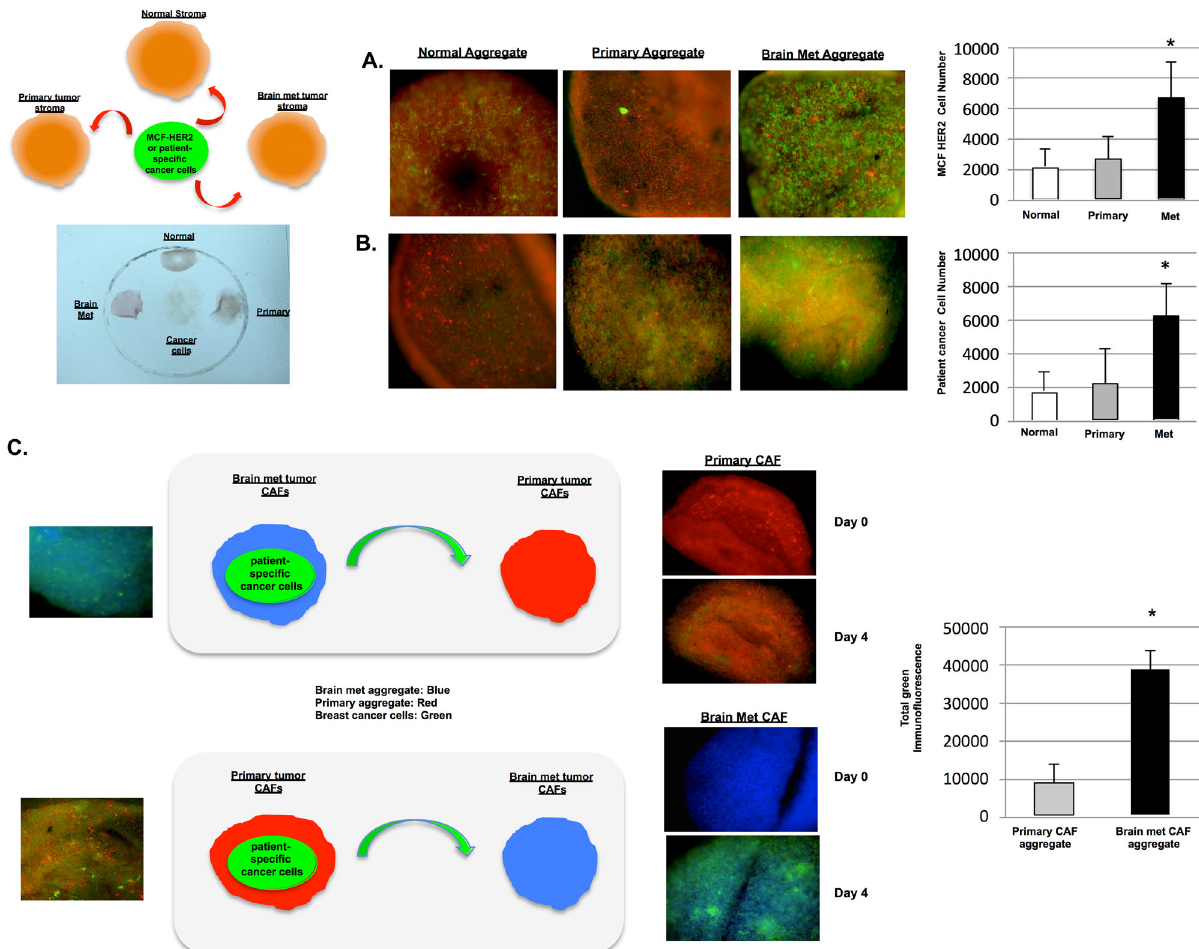
Fig. 4 Effects of CAF in migration of cancer cells in vitro. a Immuno- fl uorescent images comparing migration of cancer cell line MCF-Her2 ( Red ) to either normal, primary or metastatic patient-derived CAF aggregate. Bar graph quanti fi es relative migration of Her-2+ (CD340+) cancer cells to normal (BC69, BC82, BC97, and BC102), primary (BC80, BC95, BC105, and BC108), or metastatic (BC25, BC55, BC66, and BC70) CAF aggregates ( see Table 1). b Immuno fl uorescent images comparing migration of patient-derived cancer cells to either normal, primary or metastatic patient-derived CAF aggregate. Bar graph demonstrates relative migratory count of cancer cells to normal (BC69, BC82, BC97, and BC102), primary (BC80, BC95, BC105, and BC108), or metastatic (BC25, BC55, BC66, and BC70) CAF aggregates. c Immuno fl uorescence images compare migration of patient-speci fi c cancer cells ( green ) towards either Primary CAF ( Red ) or Brain Metastasis CAF ( Blue ) on Day 0 and Day 4. Bar graph quanti fi es relative total cell fl uorescence of patient-speci fi c cancer cells that have migrated to primary or brain metastatic CAF aggregate. ( # P <